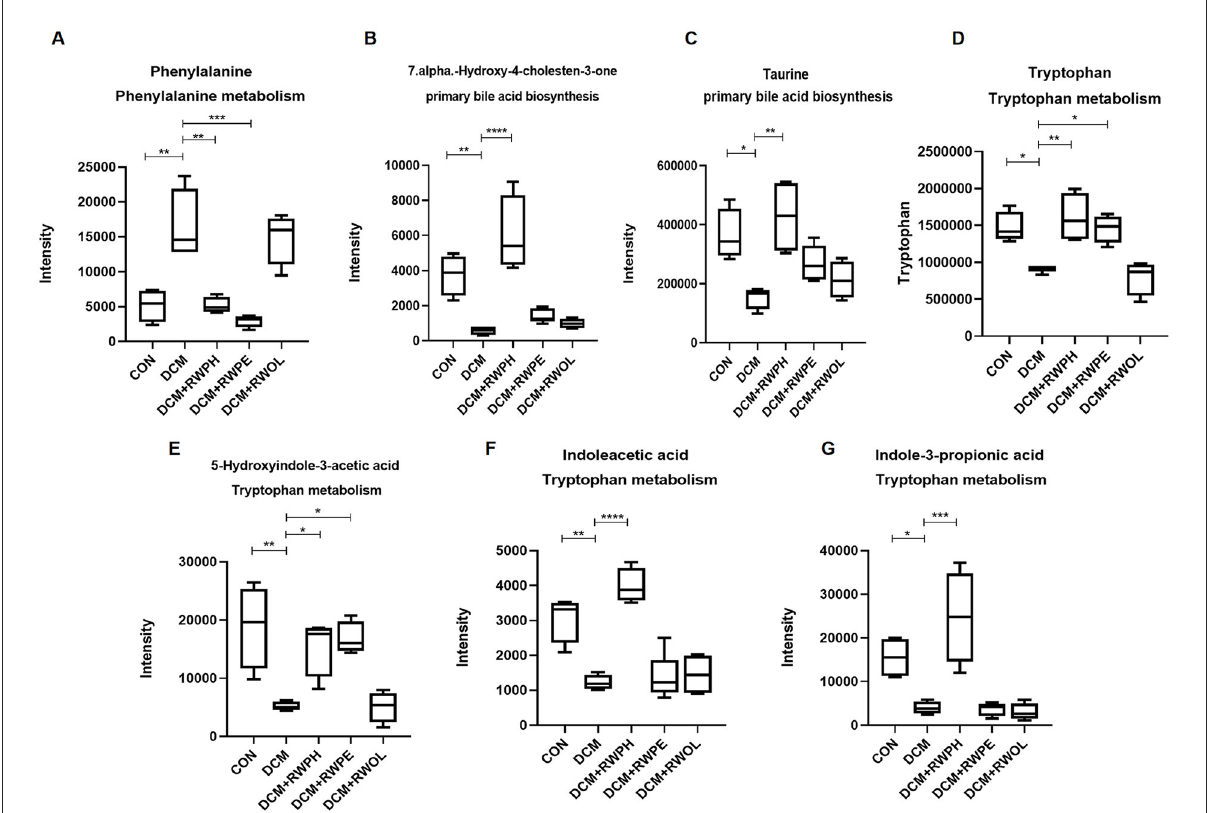
FIGURE10 Indensity comparison of representative significantly different metabolites between groups. (A–G) Indensity comparison of significantly changed metabolites among groups. * P < 0.05, ** P < 0.01, *** P < 0.001, and **** P <